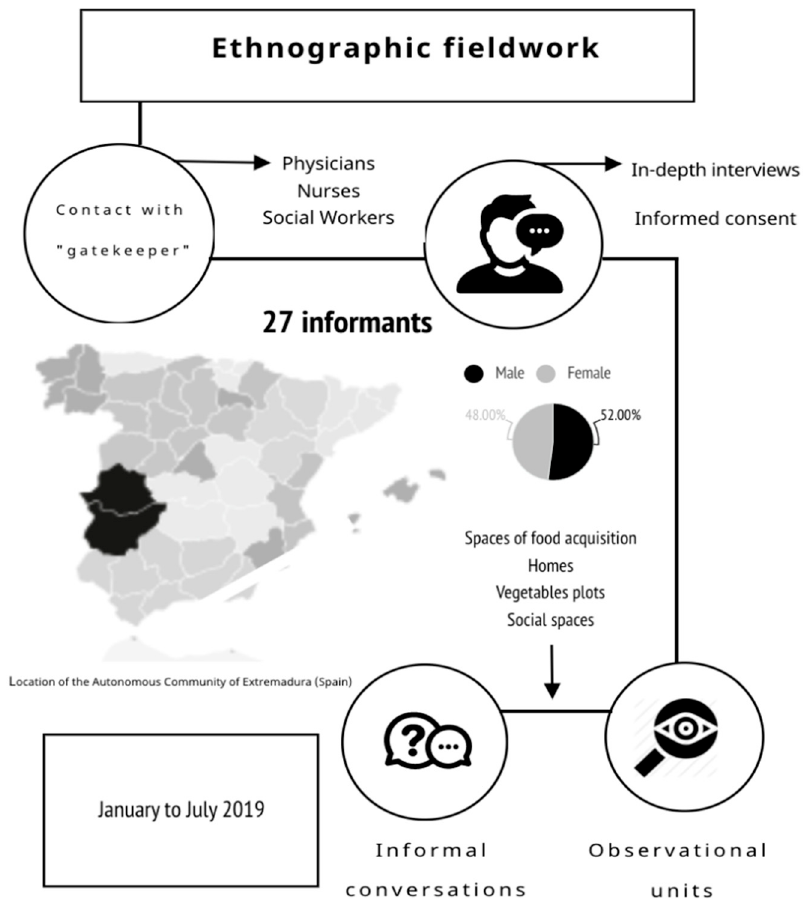
Figure 1. Framework of ethnographic fieldwork.